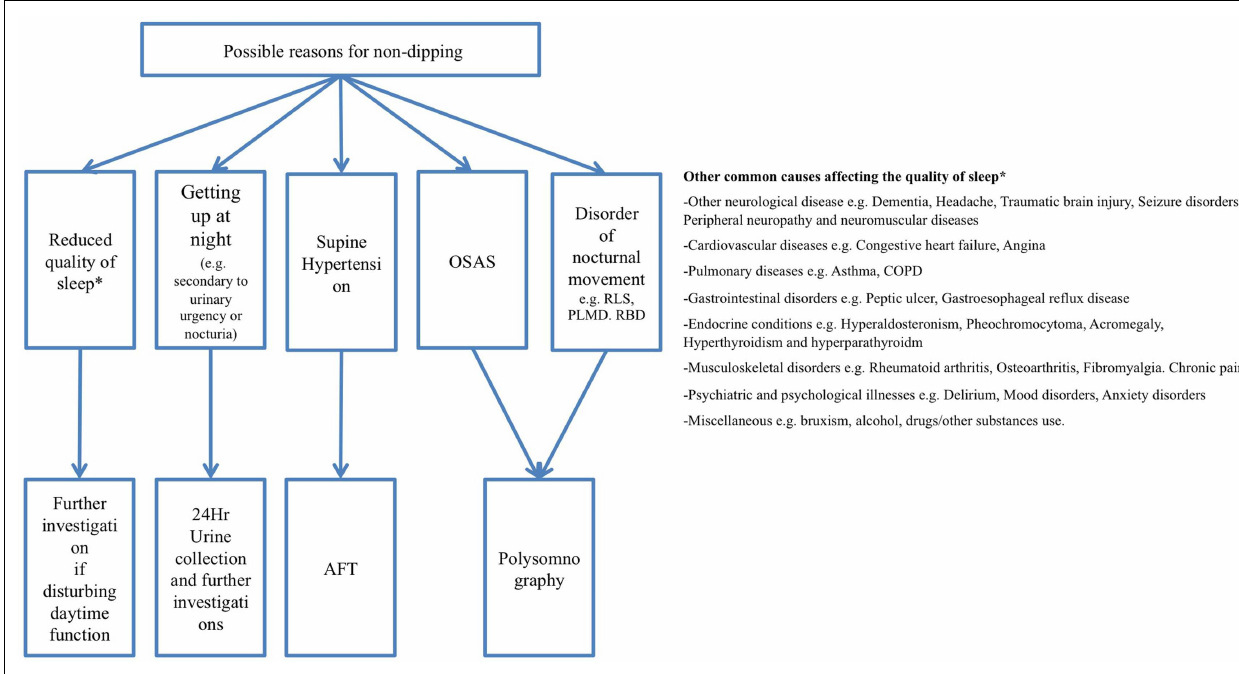
CHART 1 | Overview of possible reasons for non-dipping and how to diagnose